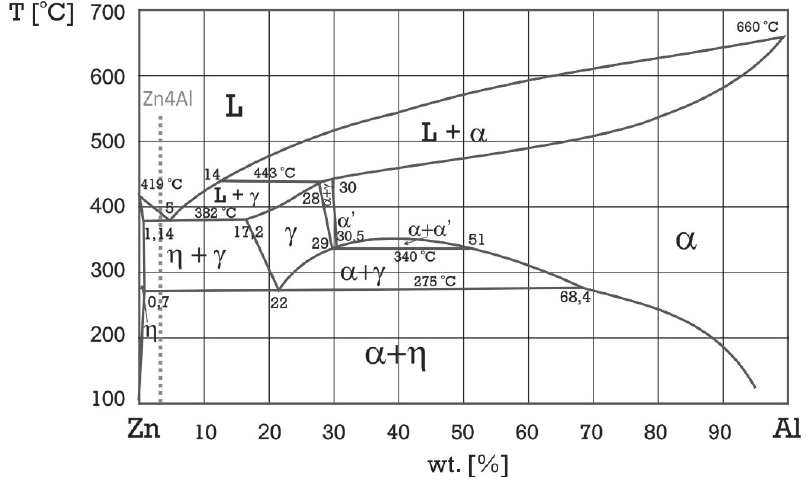
Figure 1. Zn-Al phase diagram adapted from [5].